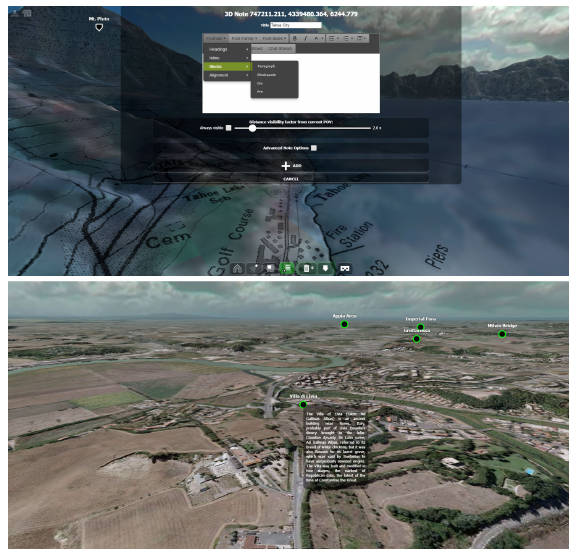
Figure 1. Aton interface and editor to insert 3D